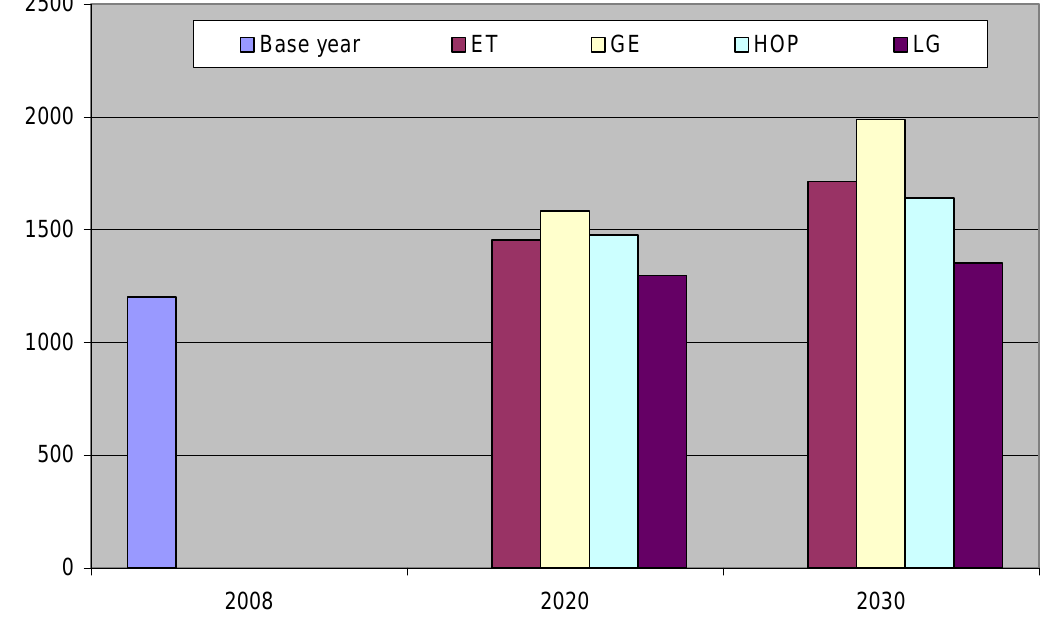
Figure 4. Overall projected cargo volumes in the HLH range Source: authors, based on projections project at Port of Rotterdam